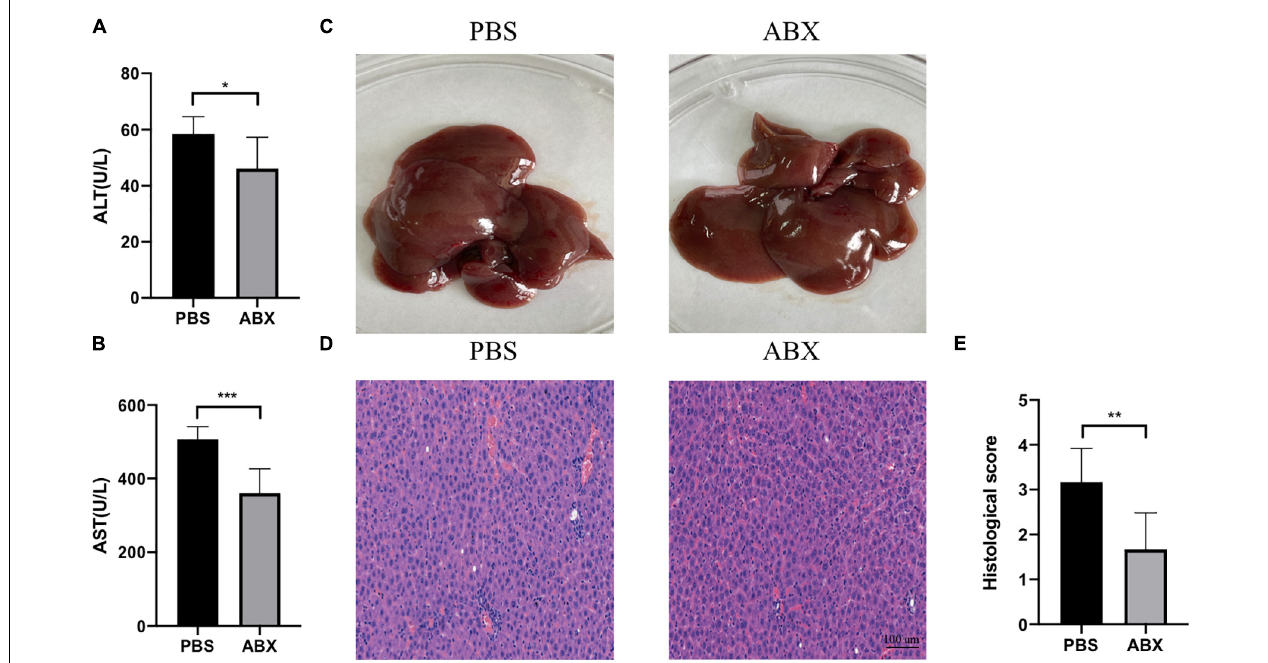
FIGURE 4 | IAH-associated liver injury was alleviated by ABX pretreatment. (A,B) The levels of plasma ALT and AST. (C) Representative liver morphology. (D,E) HE staining and histological score of liver injury (mean ± SD. * p < 0.05; ** p < 0.01; *** p < 0.001; PBS group vs. ABX group; n = 6 per group).